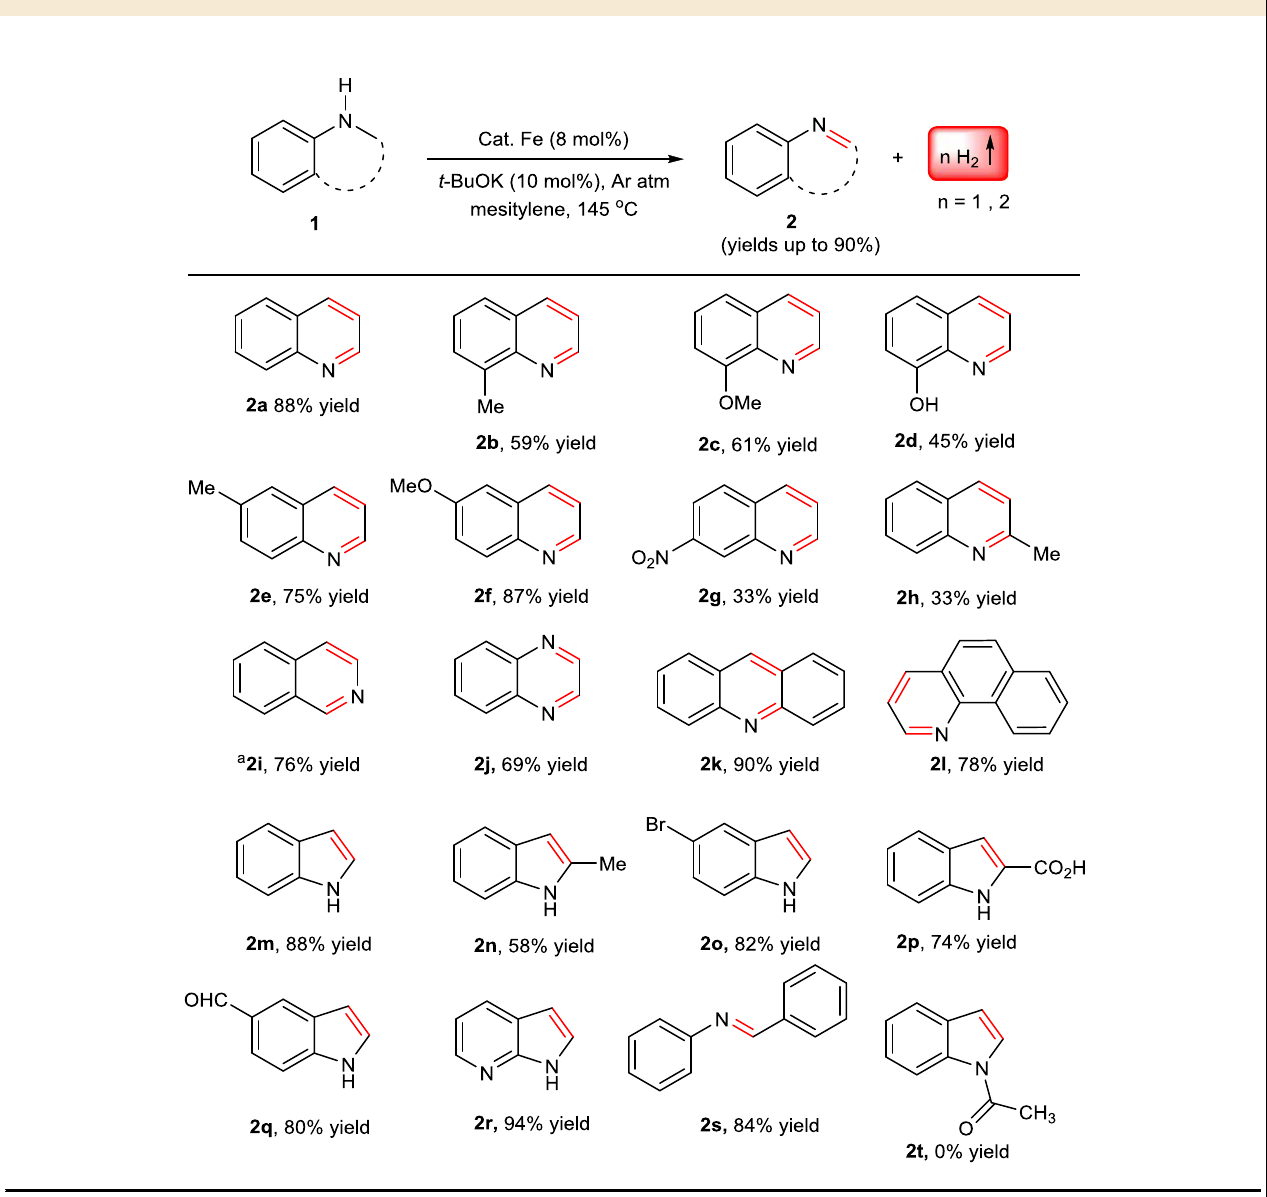
Table 2 Nanoscale iron-catalyzed acceptorless dehydrogenation of N